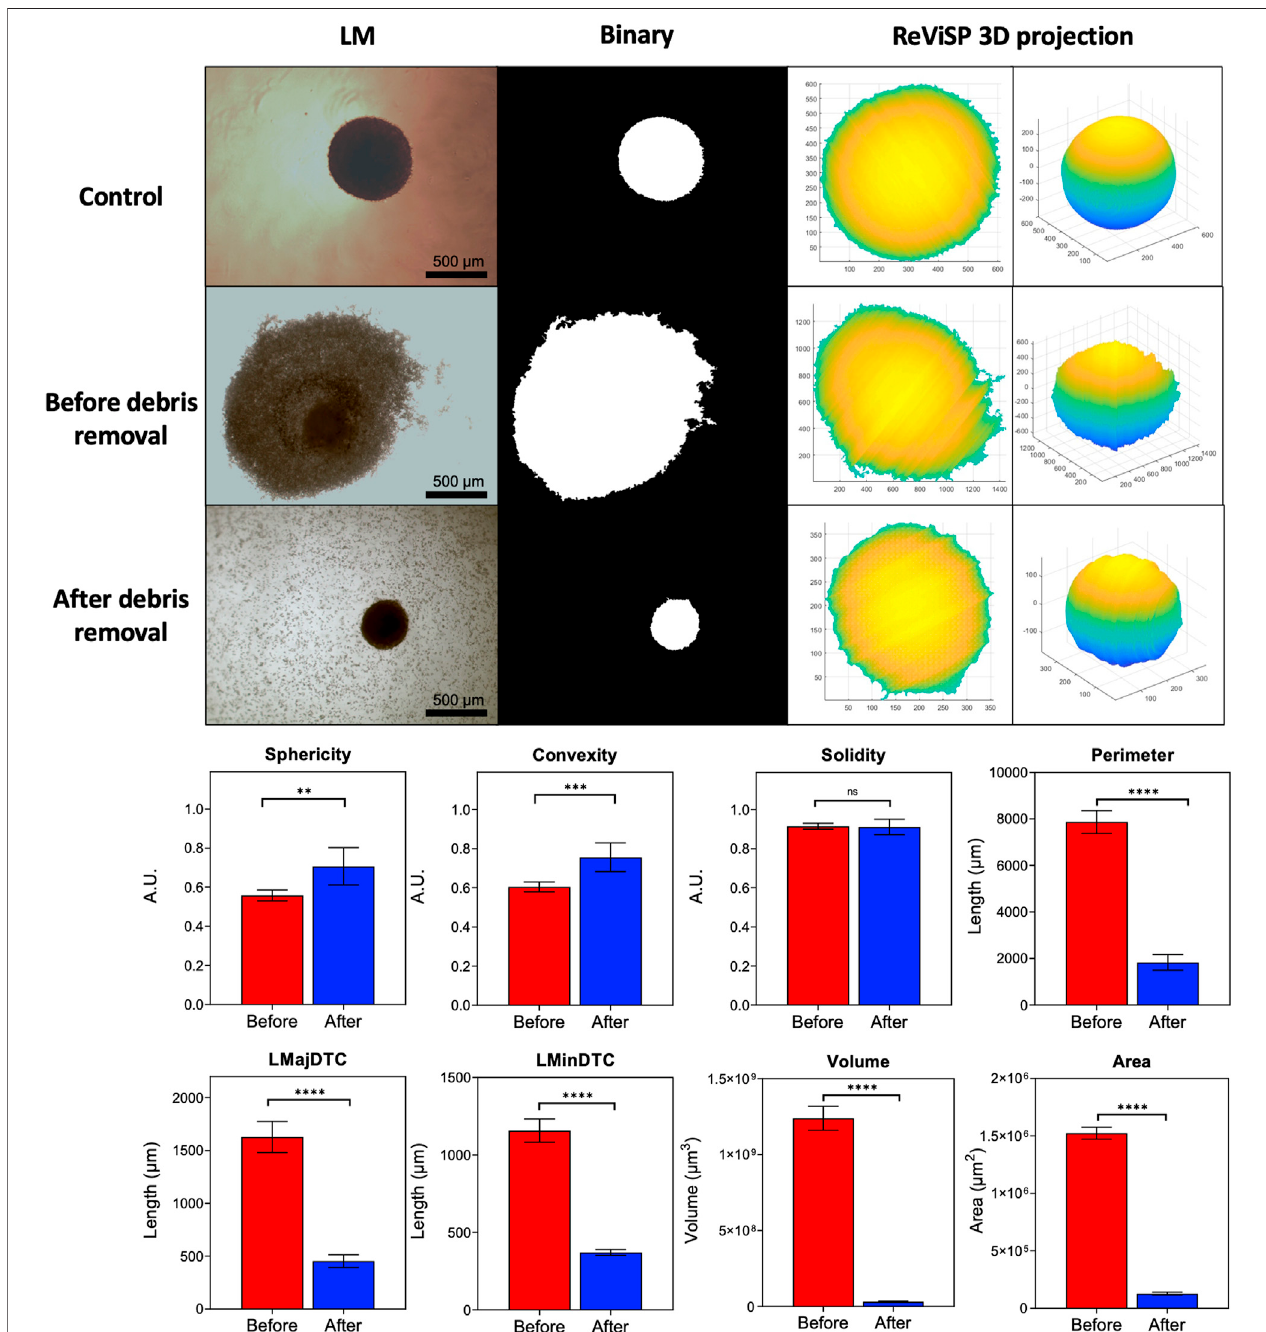
FIGURE 3 | Parameter extraction improves as debris is cleared from the well. Automatic segmentation depends on initial wide fi eld light microscope image quality. Conversiontobinarycausesaccuracytodecreaseascellulardebrisaccumulatinginthewellbottomismistakenforspheroidmass.Debrisremovalsigni fi cantlychanges extracted parameters. Area and volume are highly affected as they depend on 3D projections from the binary mask obtained with AnaSP and ReViSP. ( N (cid:1) 3, n (cid:1) 6).